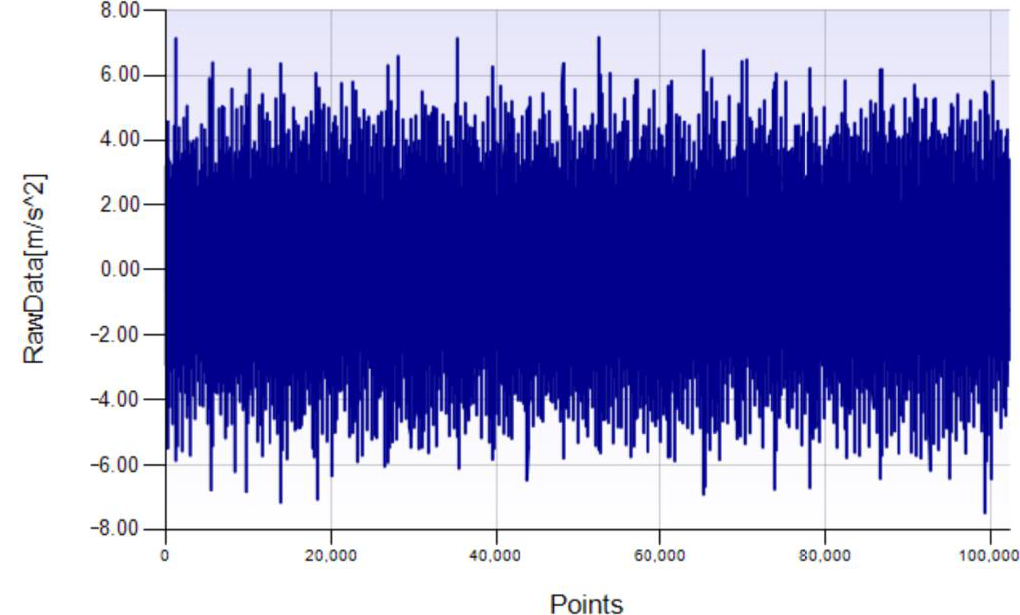
Figure 12. Time domain diagram of vibration signal of medium-speed shaft position in gearbox of wind turbine A under warning conditions.